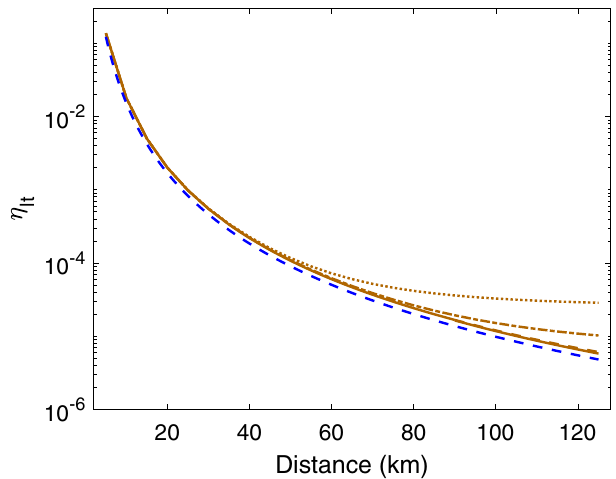
Fig. 2 Turbulence-induced transmissivity versus distance. By assuming the same parameters of Fig. 1, here we plot turbulence-induced transmissivity versus distance z < z i , where z i = 126.7 km. Brown curves from top to bottom correspond to the Huygens-Fresnel long-term transmissivity numerically computed for a 1 R ¼ 10, 20, 50 and 100 m. The lower (dashed blue) curve is the long-term transmissivity analytically computed from Eqs. (16) and (9). The latter can be assumed as limiting lower value at all